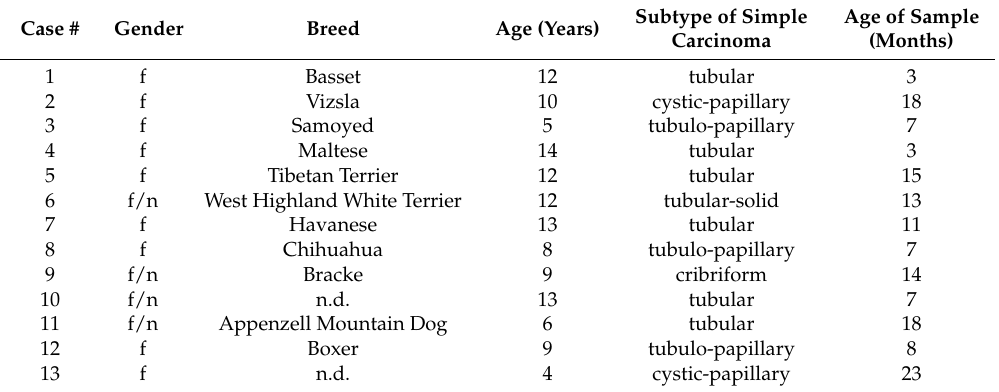
Table 1. Overview of cases included in this study. Clinical data from dogs with simple mammary carcinoma; Case # = case number as referred to within this study; f/n = female, neutered; n.d. = not disclosed; age = age at excision of tumour; age of sample = time between initial tumour excision and sampling of stroma/RNA extraction.